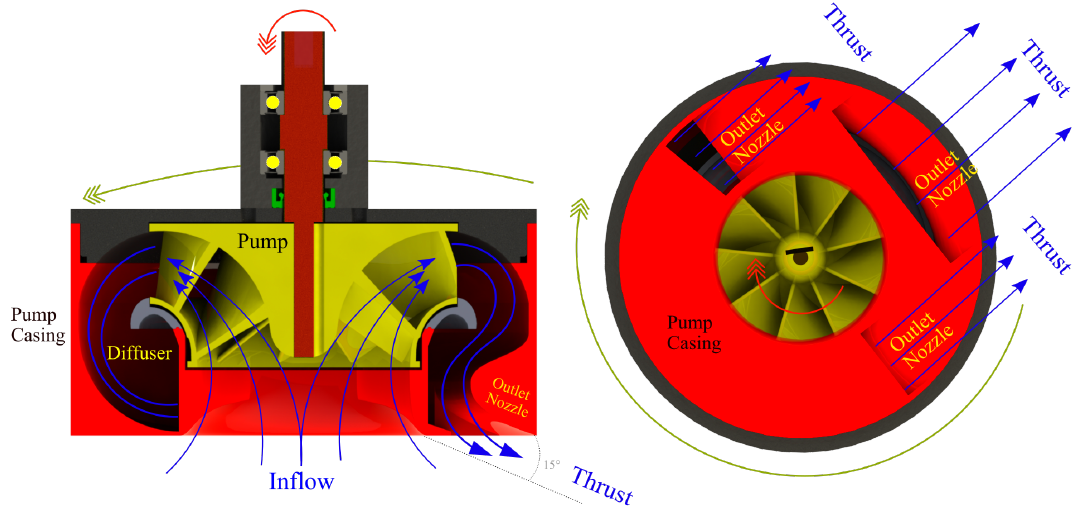
Figure 4. The pump-jet operating